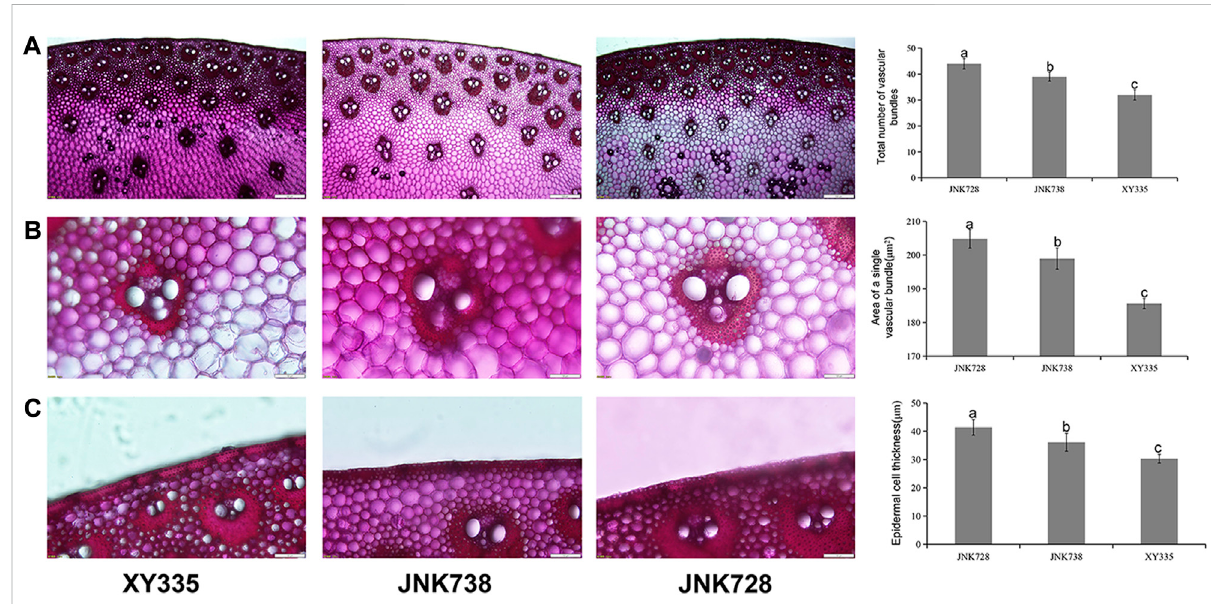
FIGURE 2 X-ray microcomputed tomography images and vascular bundle traits of the three hybrid cultivars. (A) The total number of vascular bundles of XY335, JNK738, and JNK728, respectively. (B) Individual vascular bundle area of XY335, JNK738, and JNK728, respectively. (C) Epidermal cell thickness of XY335, JNK738, and JNK728,